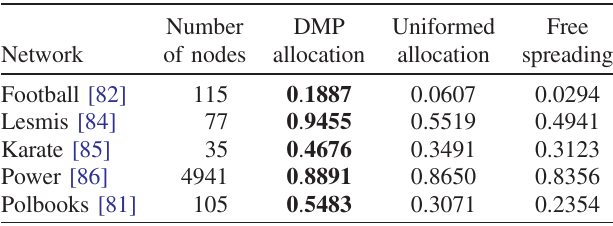
TABLE VI. Different vaccine-allocation policies in a collabo- rative process on different benchmark networks. On each net- work, we randomly choose 0 . 05 N of the nodes as seeds for process B and 0 . 01 N nodes as seeds for process A ; the total vaccination budget is 0 . 05 N , where N is the number of nodes in the network. Infection parameters are arbitrarily set to α A ¼ 0 . 4 , α 0 . 4 , α 0 . 9 , and α 0 . 9 . The parameter ϵ in Eq. (F2) B ¼ AB ¼ BA ¼ is set to 0.01. The optimization procedure is iterated 10 times, and the best result is selected. The objective is to minimize the spreading of processes A and B , i.e., maximize the fraction of P P i T Þ =N at the end of the process (time susceptible nodes i S ð T ¼ 3 ). In DMP-based optimal allocation, we assume that all budgets are available at time zero. Uniform allocation assumes all budgets to be uniformly allocated to all nodes at time zero. In